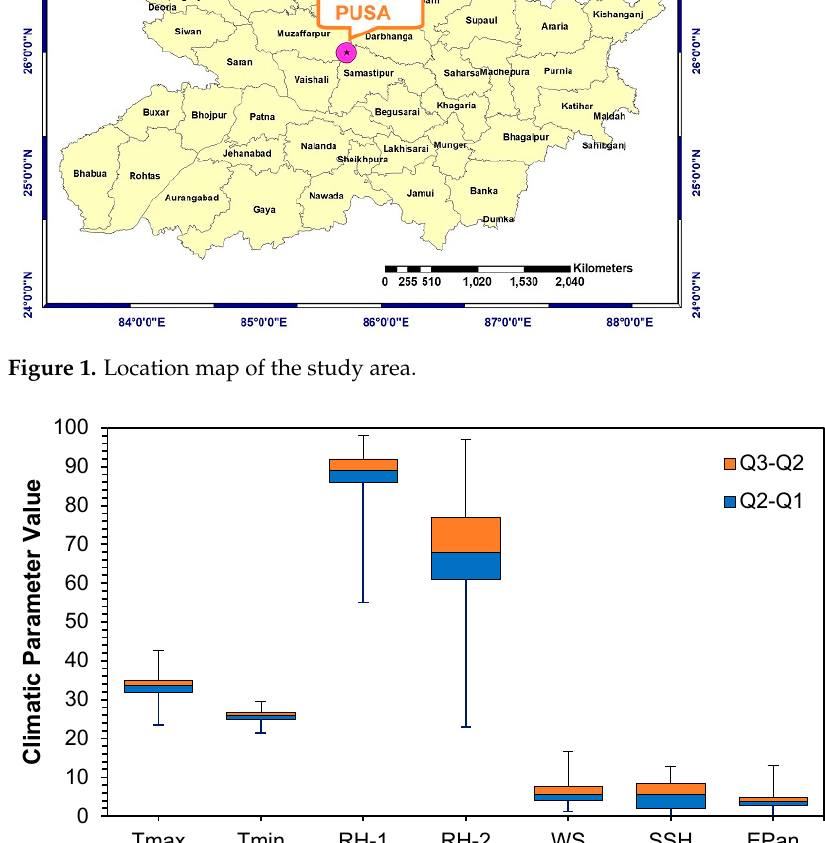
Figure 2. Box-and-whisker plot of climatic parameters in the study area. The box-and-whisker plot shows that the relative humidity, measured at 7 a.m. and 2 p.m., respectively, demonstrates the highest variability among other meteorological